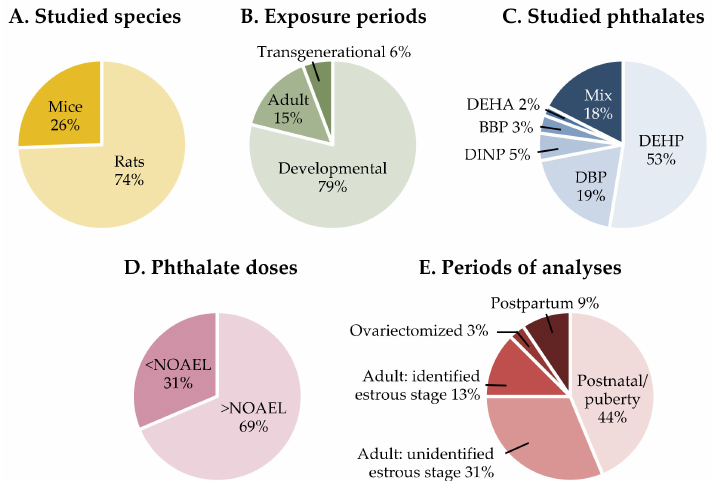
Figure 2. Summary information on the experimental conditions used in the studies discussed in the present review. DEHP, Di-(2-ethylexyl) phthalate; DBP, Dibutyl phthalate; DINP, Diisononyl phthalate; BBP, Benzyl butyl phthalate; DEHA, Di-(2-ethylhexyl) adipate; NOAEL, non-observed adverse effect